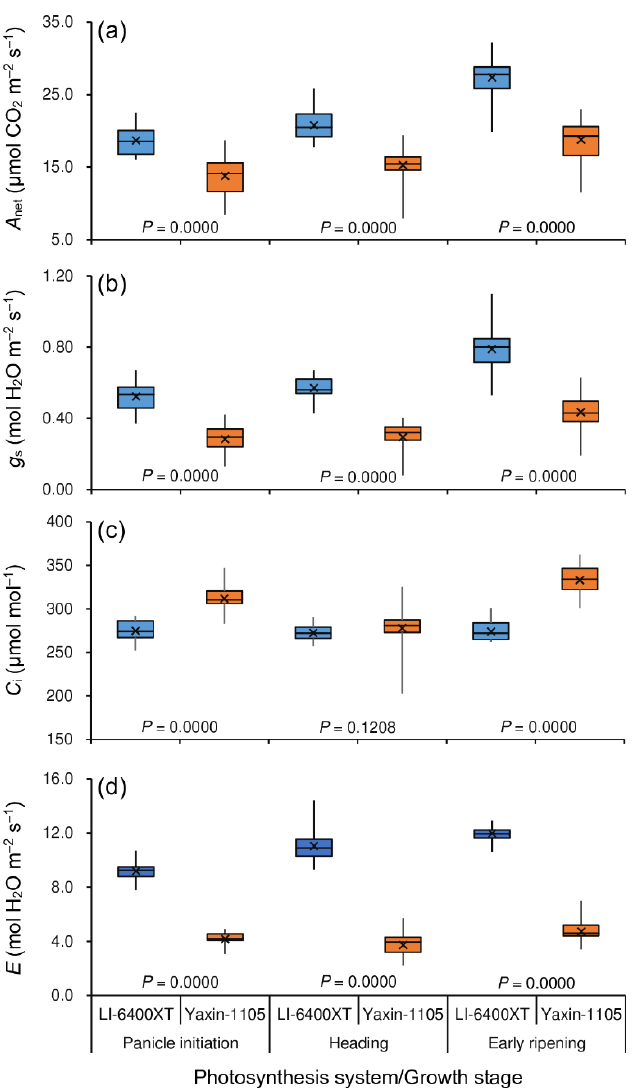
Figure 1. ( a ) Net photosynthetic rate ( A net ), ( b ) stomatal conductance ( g s ), ( c ) intercellular CO 2 concentration ( C i ), and ( d ) transpiration rate ( E ) in rice leaves measured by both Yaxin-1105 and LI-6400XT. The box-and-whisker plot shows the minimum (end of the lower whisker), 25th percentile (lower edge of the box), median (horizontal line within the box), mean (cross within the box), 75th percentile (upper edge of the box), and maximum (end of the upper whisker) values of the data.